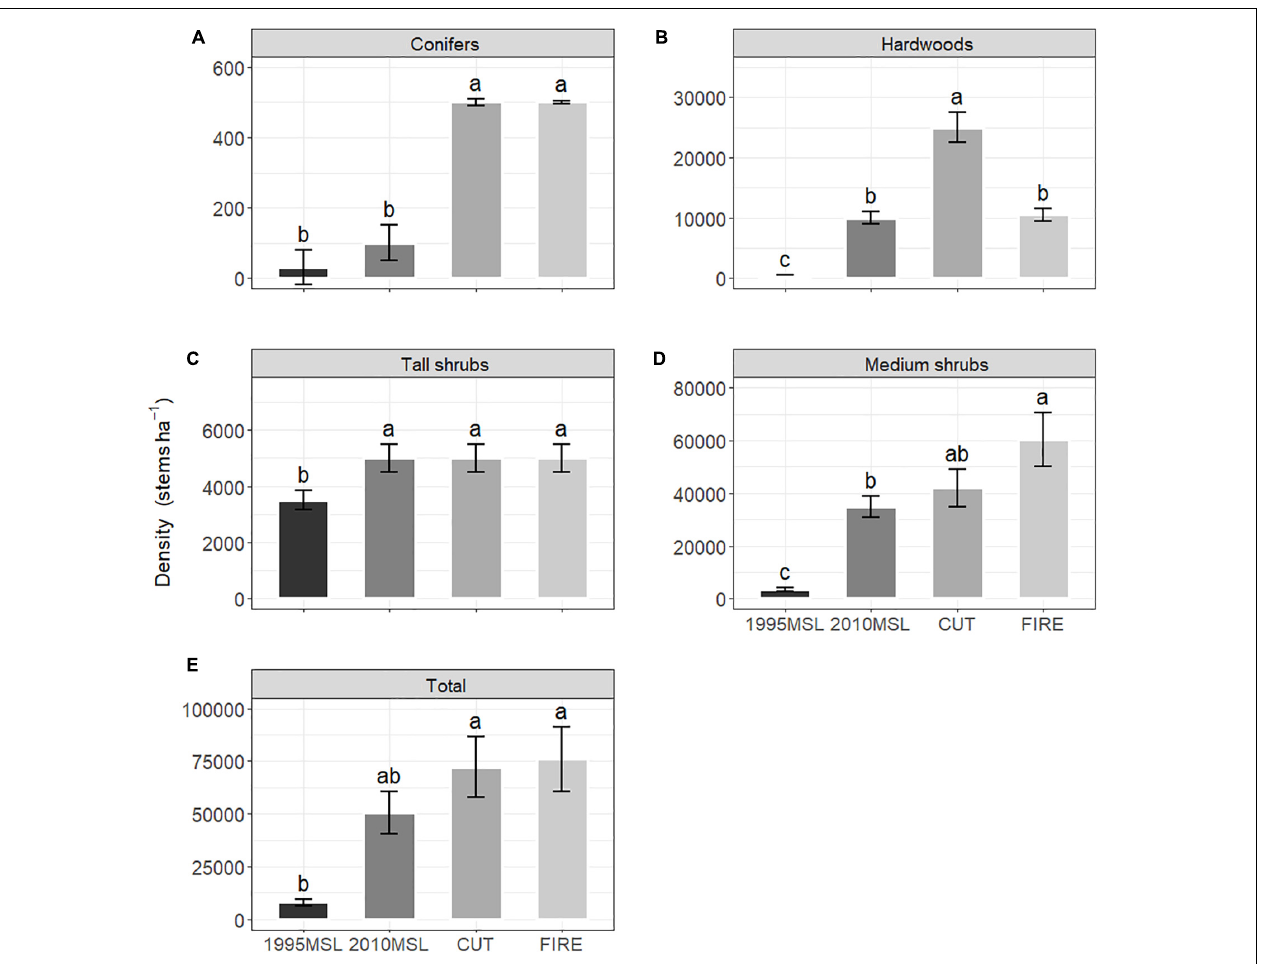
FIGURE 3 | Least squares means conifers (A) , hardwoods (B) , tall and medium shrubs (C,D) , and total (E) stem density by reclaimed (1995 and 2010MSL) and reference (CUT and FIRE) site types. Mean ( ± SE) values with a different lowercase letter(s) were significantly different among the site types at P <